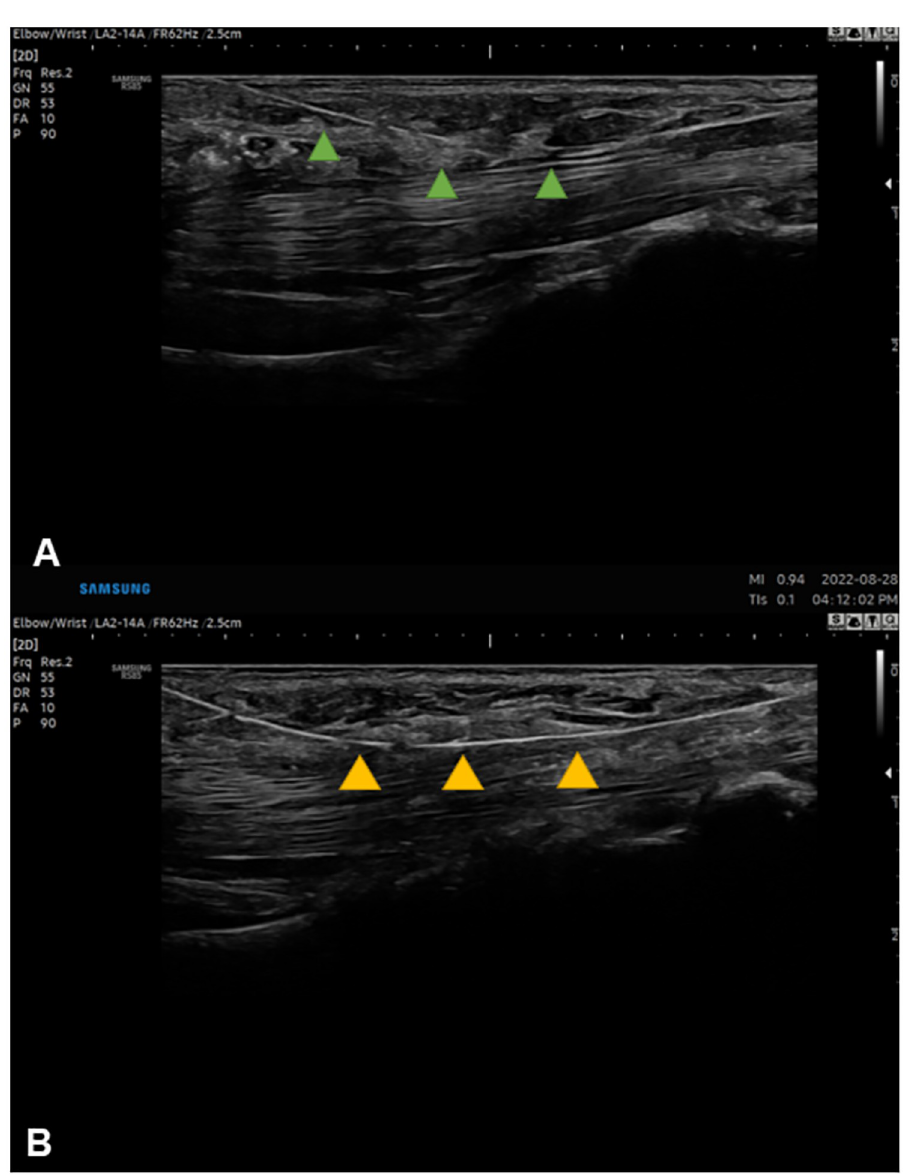
Fig 5. Ultrasound images of both threads in same settings. A, green arrows: Loop & Shear. B, yellow arrows: Smartwire-01.